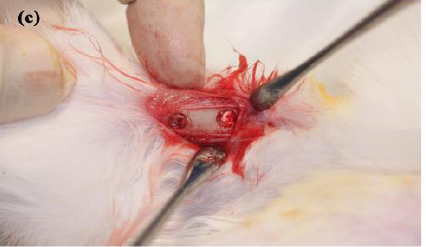
Figure 1. Procedure of animal experiment. ( a ) The tibia of the rabbit was scraped, ( b ) two implantation holes with a diameter of 4 mm were prepared at each tibia of the rabbit, ( c ) neat PLLA was grafted into one implantation site and Fe 3 O 4 /PLLA nanofibers were grafted into the other.